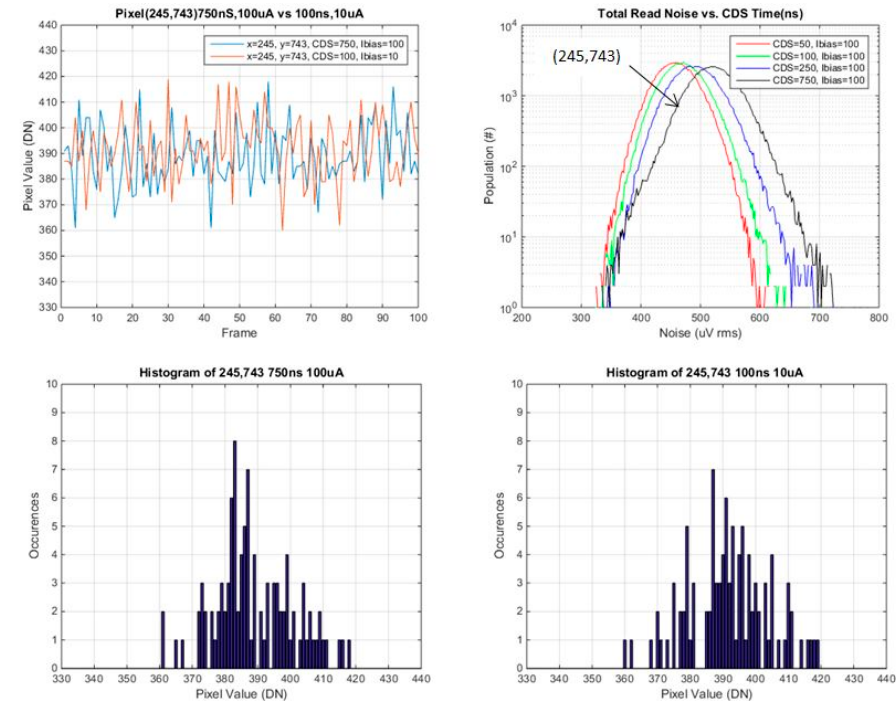
Figure 17. Pixel value vs. frame, and histogram of pixel values for pixel 245,743 (from below the mode of the noise histogram).